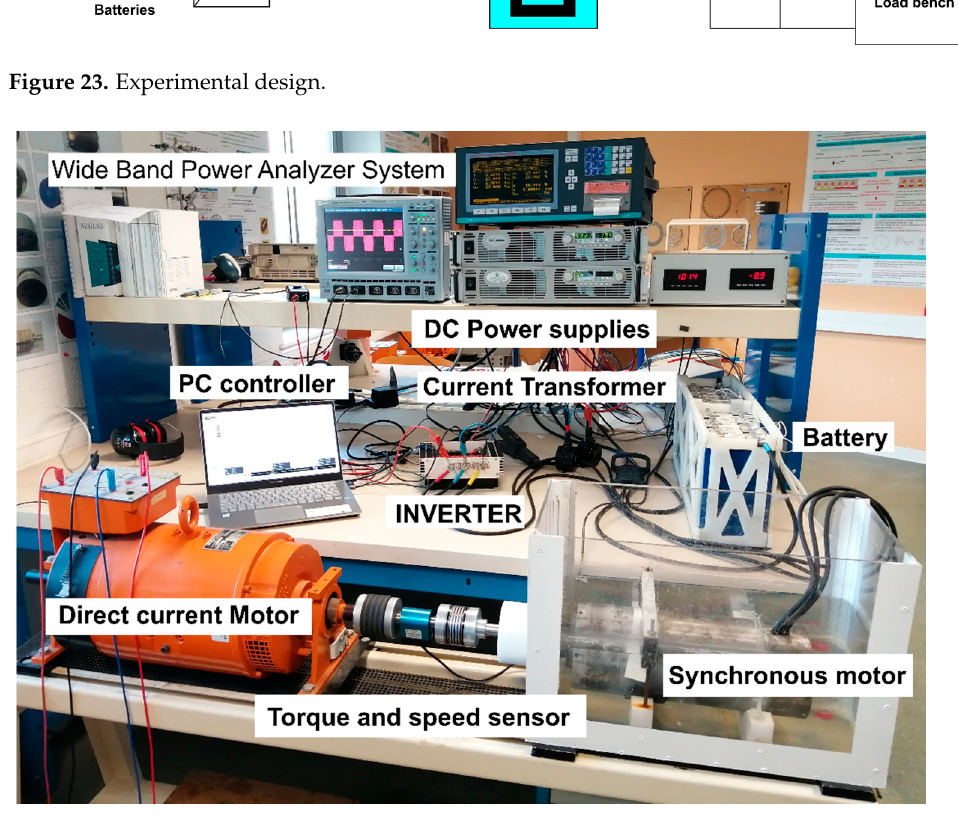
Figure 24. Test Bench.